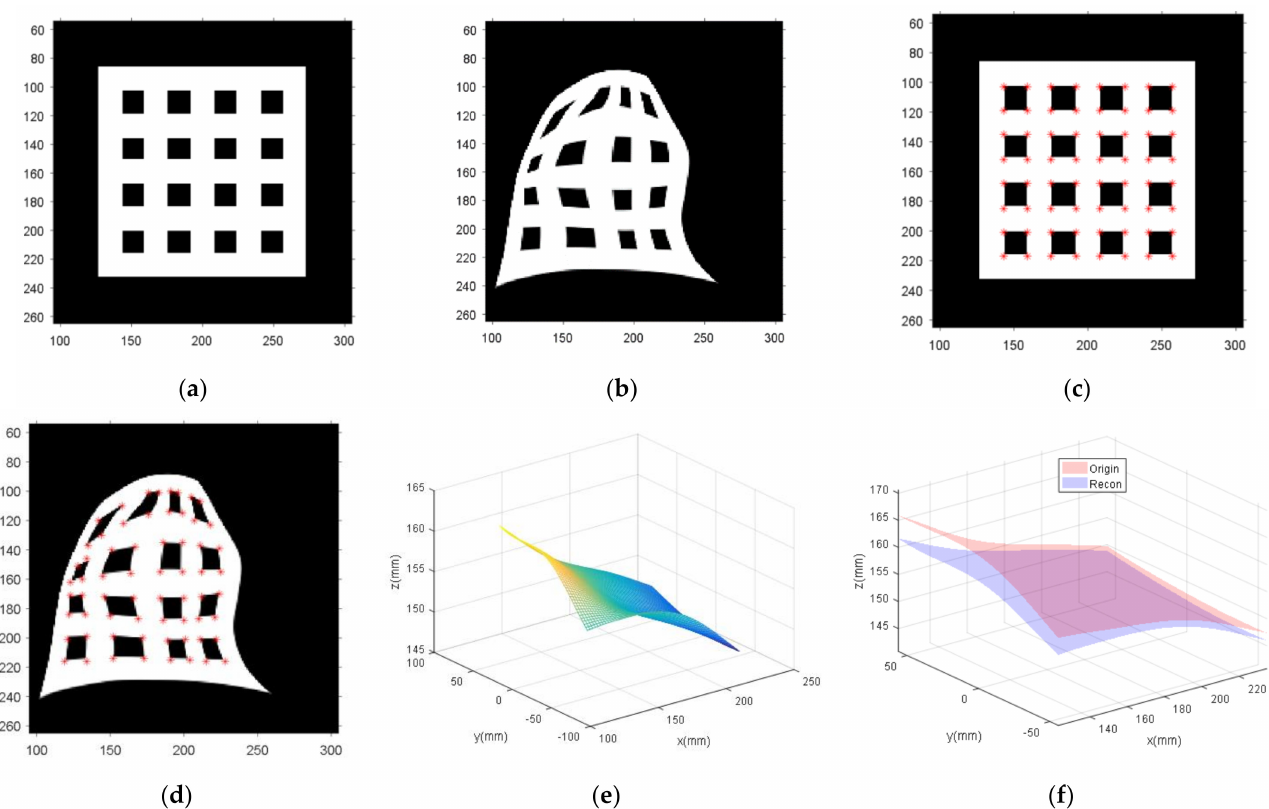
Figure 11. Simulation for WAI shape reconstruction. ( a ) Reference structured light image. ( b ) Dis- torted structured light image. ( c ) Results of feature point extraction for the reference structure light image using the method of Ref. [34]. ( d ) Results of feature point extraction for the distorted structured light image using the method of Ref. [34]. ( e ) Recovered WAI shape. ( f ) Ground-truth WAI [red] and reconstructed WAI [blue].